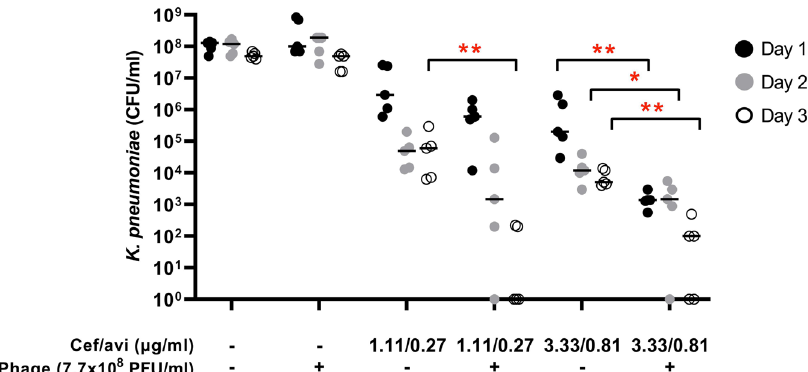
Fig. 8 Activity of preadapted phage M1, ceftazidime/avibactam, and combinations thereof against PDR K. pneumoniae isolate Kp36336 residing